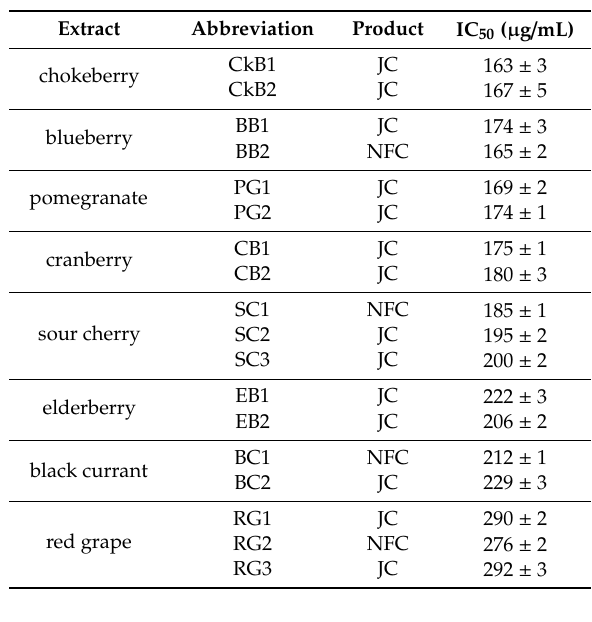
Table 3. Half-maximal inhibitory concentrations (IC 50 ) of the 18 di ff erent juice extracts tested using the PDE activity assay. Results are presented as mean ± SD ( n = 3–4). JC (juice concentrate), NFC (not from